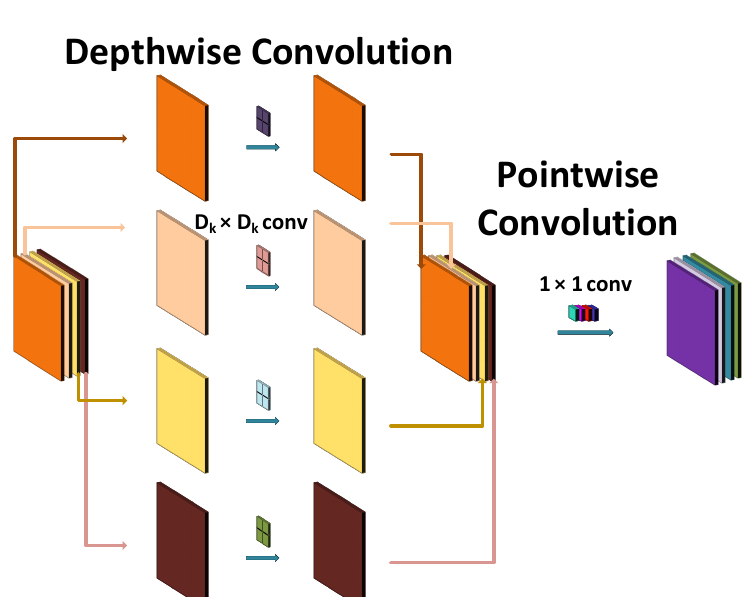
Figure 15. Depthwise separable convolution—principle of